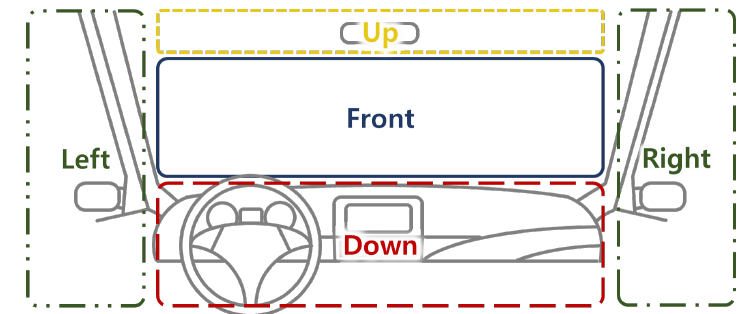
Figure 4. Head direction estimation in this paper.